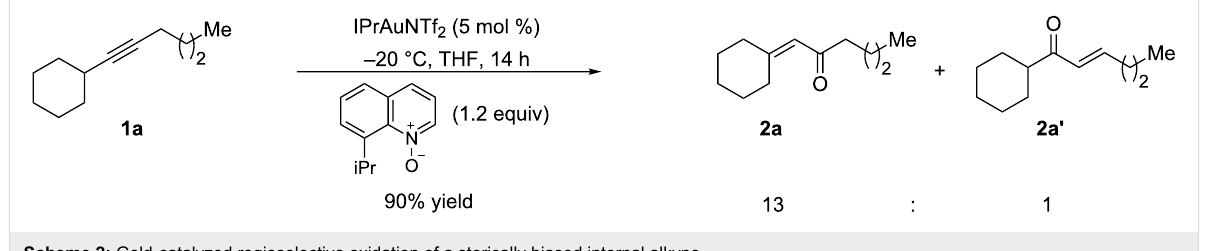
Scheme 2: Gold-catalyzed regioselective oxidation of a sterically biased internal